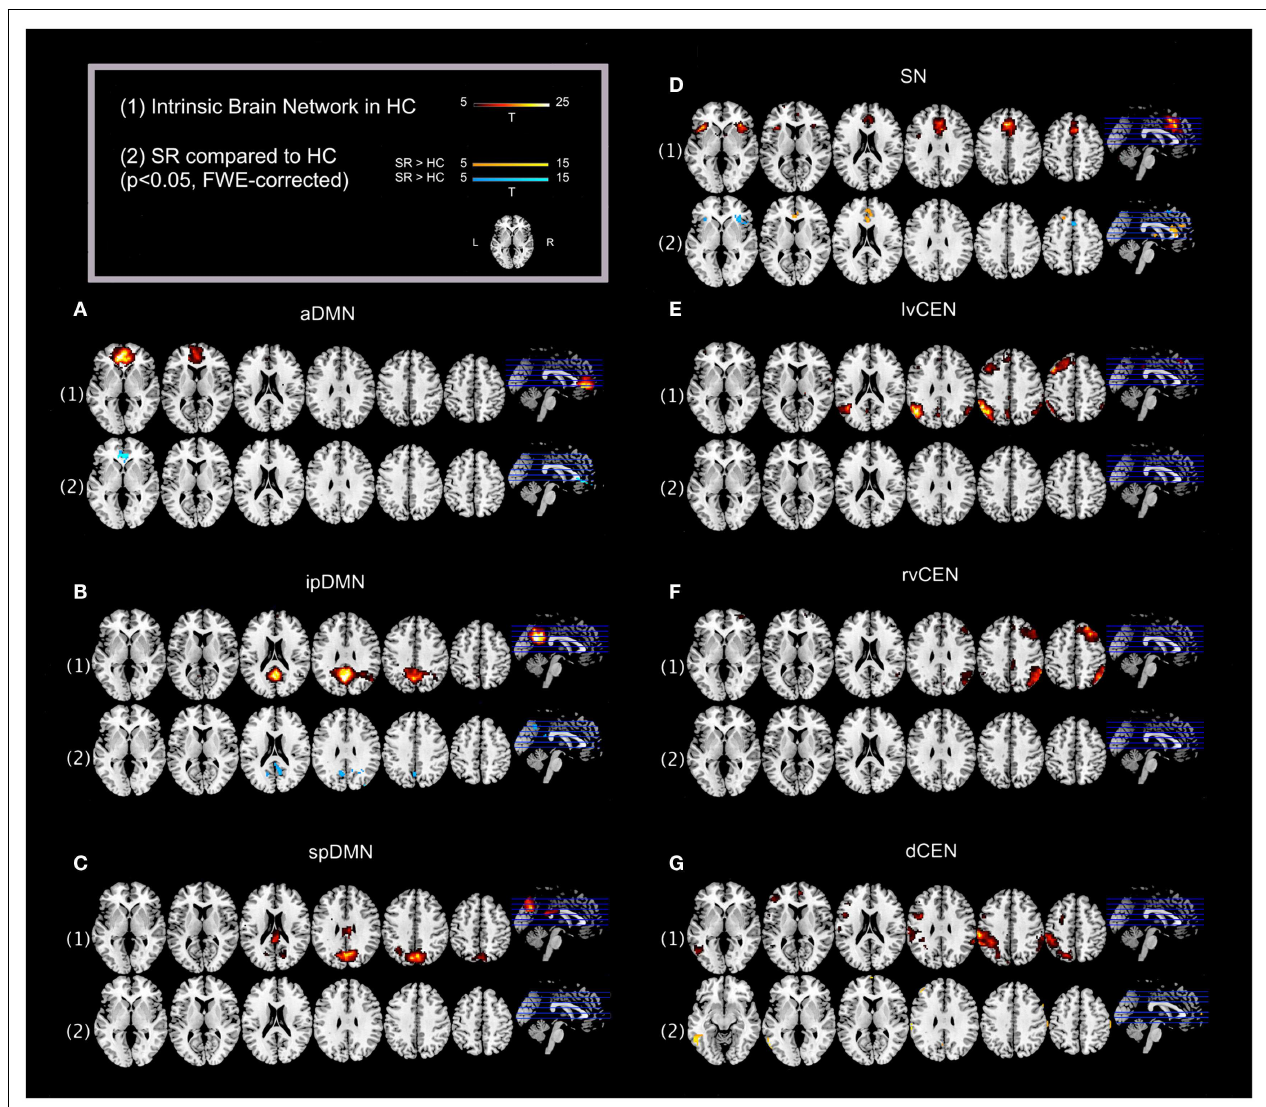
volume as covariates of no interest and thresholded at p < 0.05, FWE-corrected. SPMs were superimposed on a single-subject high resolution T1 image (color scale representing t -values from 5 to 15; yellow (“hot”) color maps indicate regions displaying higher intra-iFC in SR compared to HC; blue (“cold”) color maps indicate regions displaying less intra-iFC in SR compared to HC). Results for each network of interest are presented panel-wise: (A) anterior default mode network (aDMN); (B) inferior-posterior default mode network (ipDMN); (C) superior-posterior default-mode network; (D) salience network (SN); (E) left-ventral central executive network (lvCEN); (F) right-ventral central executive network (rvCEN); (G) dorsal central executive network (dCEN). SR, group of patients with schizophrenia during remission; HC, healthy control group (see also Tables 3 and 4 ).